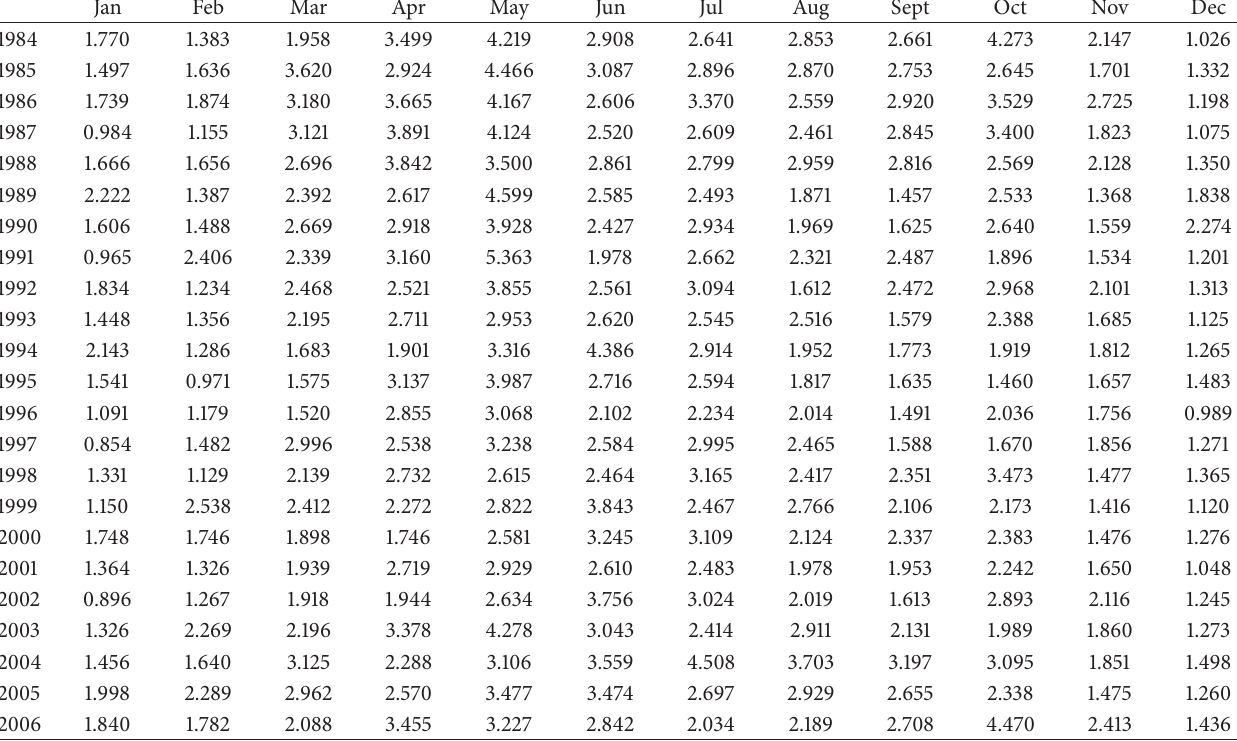
Table 3: WS of FS statistics for the